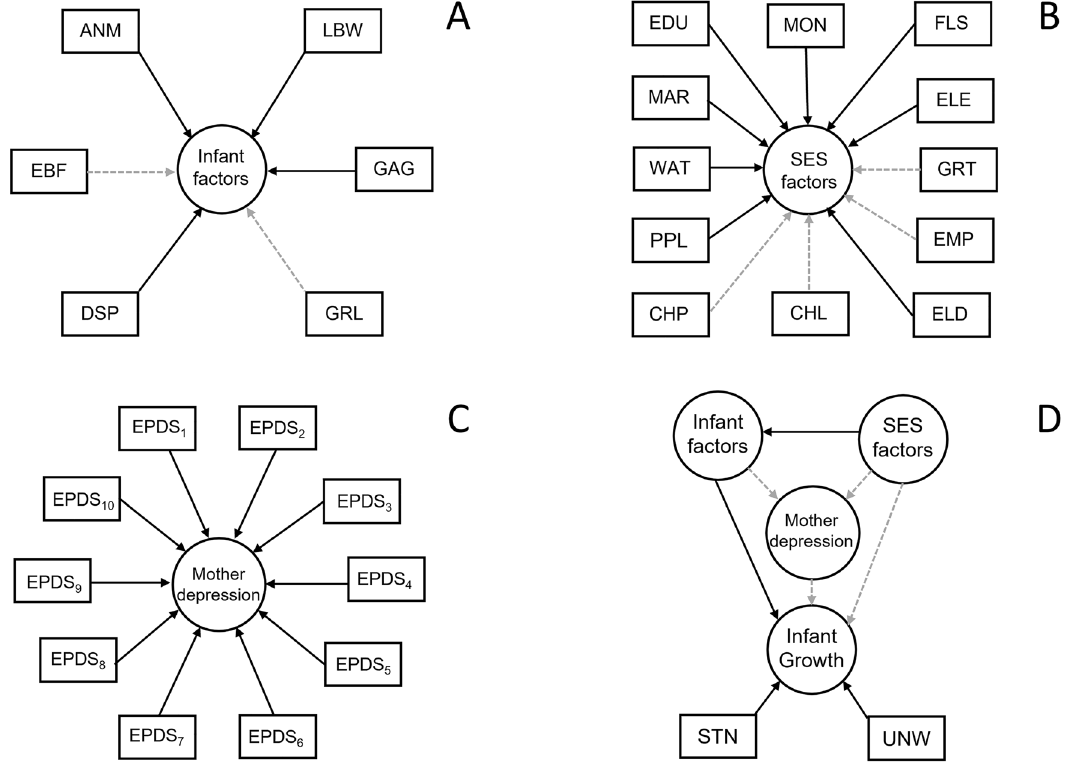
Figure 1. Results from the latent factor model analysis. Correlations between instrumental variables (Rectangles) and latent factors (circles) were reported on Panels ( A ), ( B ) and ( C ). Overall latent factor model was reported on panel ( D ). Solid black arrows represent statistically significant associations according to the Benjamini–Hochberg